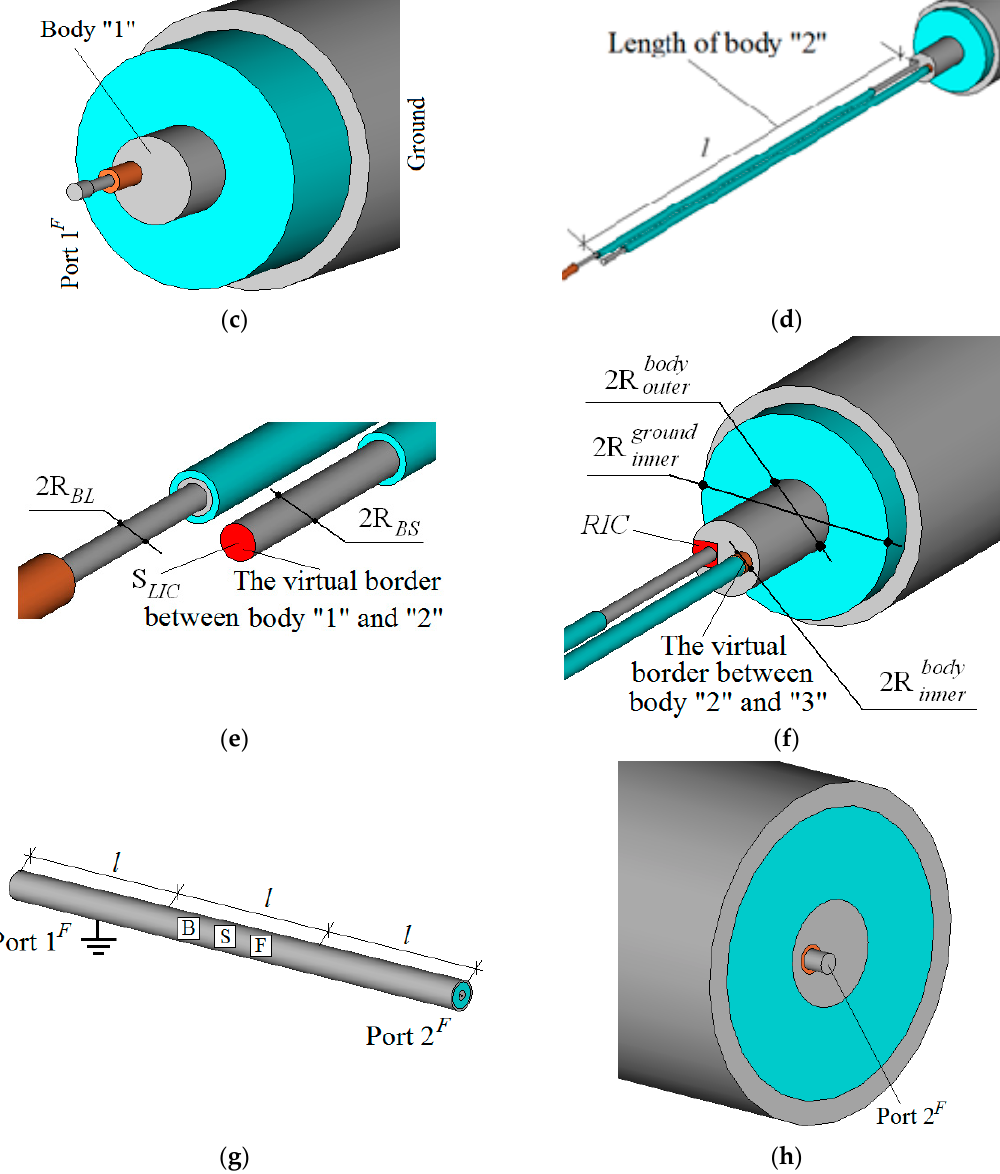
Figure 4. Proposed coaxial bandstop filter: ( a ) general 3D view, ( b ) 3D view of the left butt-end (fine scale), ( c ) the latest 3D view on the very fine scale, ( d ) 3D view of the entirety of body “2” (fine scale), ( e ) 3D view of the region near the left virtual border of body “2” (very fine scale), ( f ) 3D view of the region near the right virtual border of body “2” (the same scale), ( g ) general 3D view in the other foreshortening, ( h ) 3D view of the right butt-end of the filter with the second port location (fine scale). LIC:left interconnection; RIC: right interconnection.